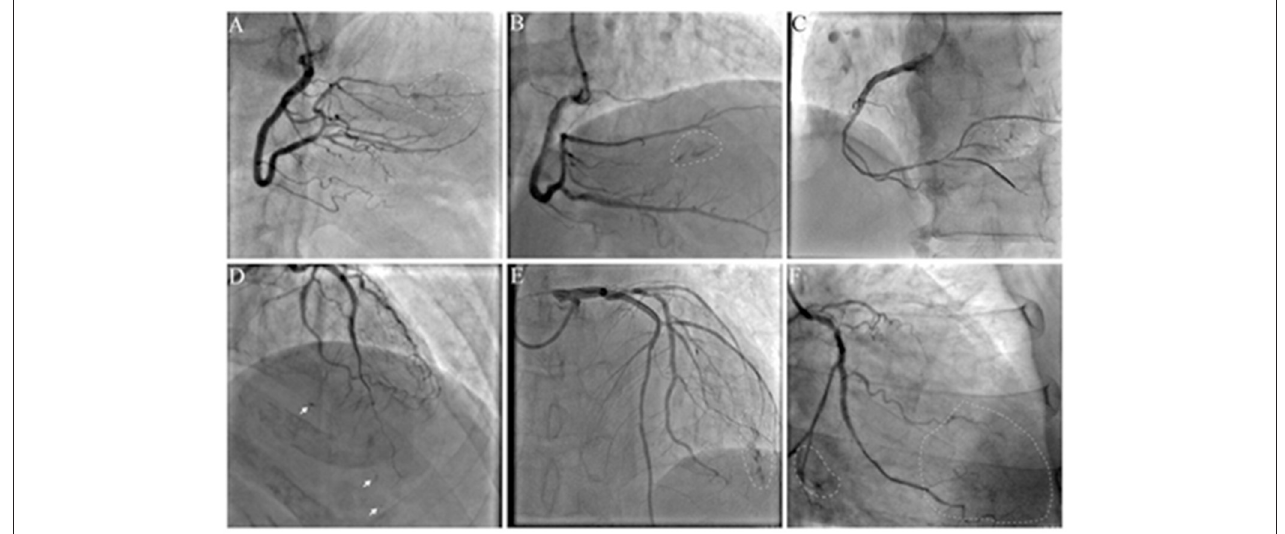
FIGURE 2 | Angiographic characteristics of acquired coronary fistulas (ACFs): multiple, diffuse, and tiny. (A–C) ACFs were found after right coronary artery (RCA) chronic total occlusion-percutaneous coronary intervention (CTO-PCI); (D,E) ACFs were found after left anterior descending (LAD) CTO-PCI; (F) ACFs were found after left circumflex coronary artery (LCX) CTO-PCI. Arrow: spot fistulas; circle: flake fistulas; Supplementary Movies 1 – 6 show angiographic findings.